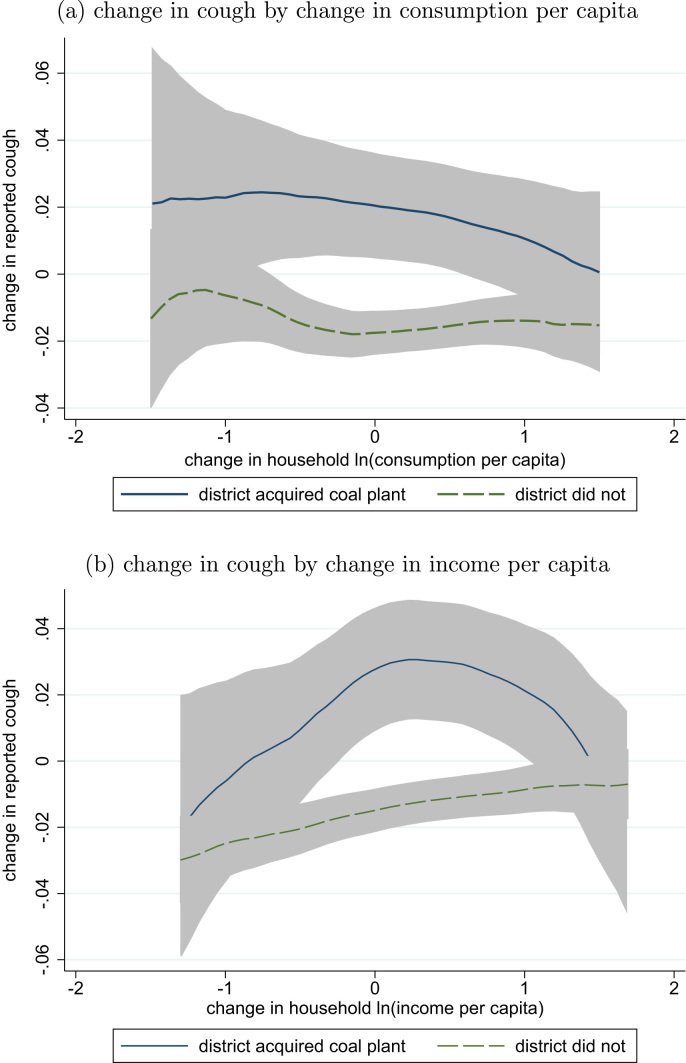
Change in reported cough for districts with and without coal expansions, by change in household economic well-being. Locally weighted regressions. Data: India Human Development Survey I (2005) and II (2012). n=79,968 observations of change over these seven years for 39,984 households.